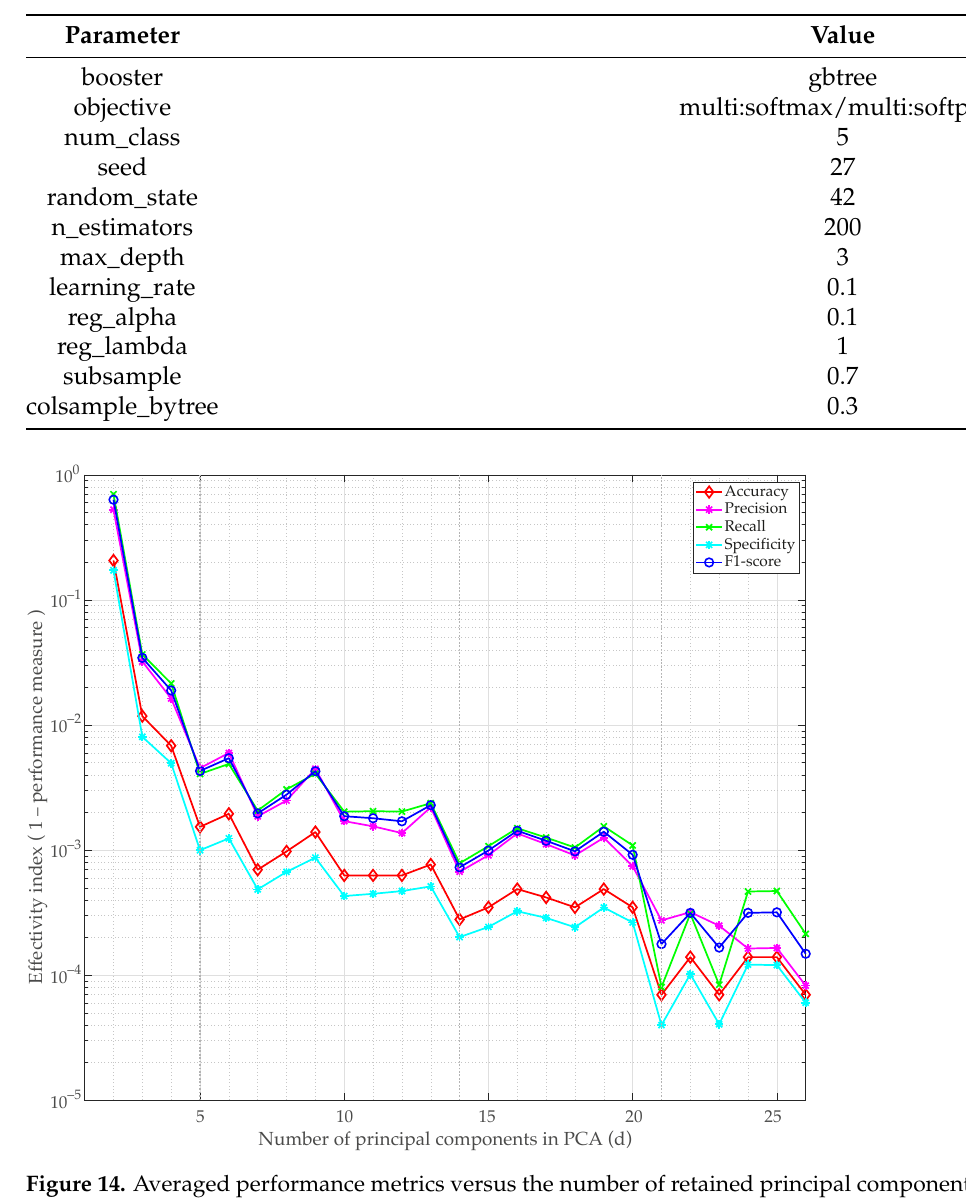
Table 6. XGBoost parameters.